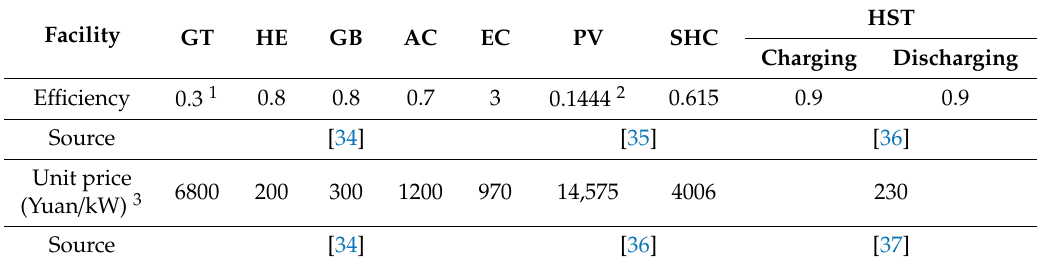
Table A2. E ffi ciency and unit price of the facilities in the hybrid CCHP